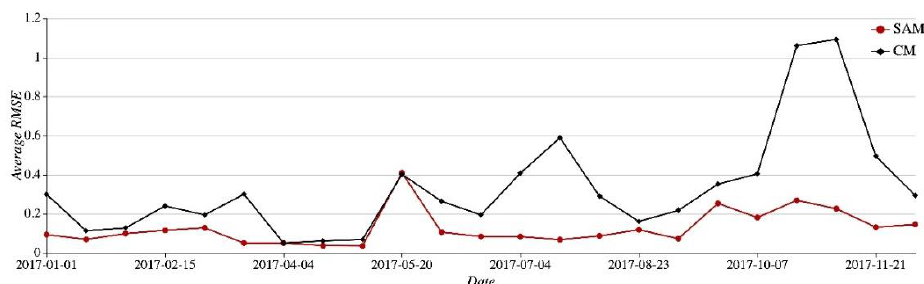
Figure 12. Average RMSE with SAM and CM in the 15 days interval.